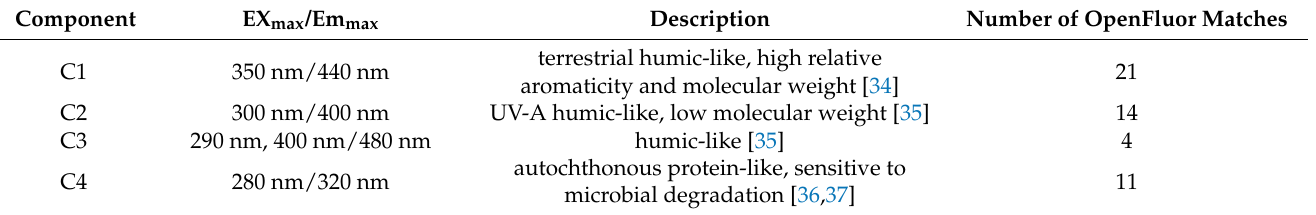
Figure 8. The results of PARAFAC analysis on FU dataset. The loading maps on the right show the result of split-half validation. Table 2. Spectral characteristics of EEMs from comparing result of PARAFAC components and OpenFluor database .